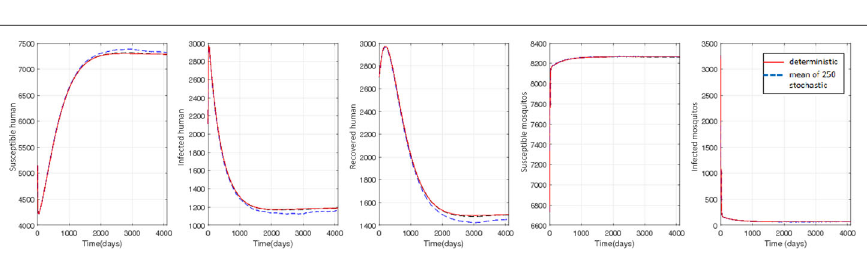
Figure 11 Model simulation with fumigation and without bed nets when R 0 >